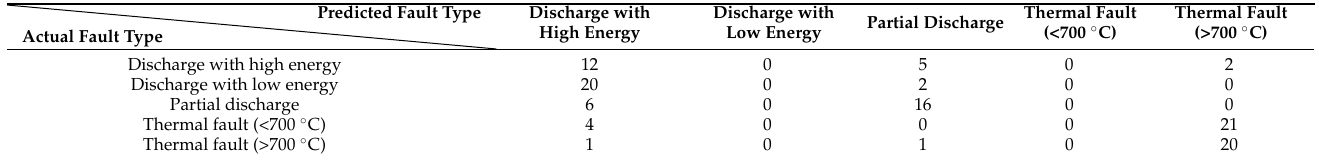
Table 8. Confusion matrix of